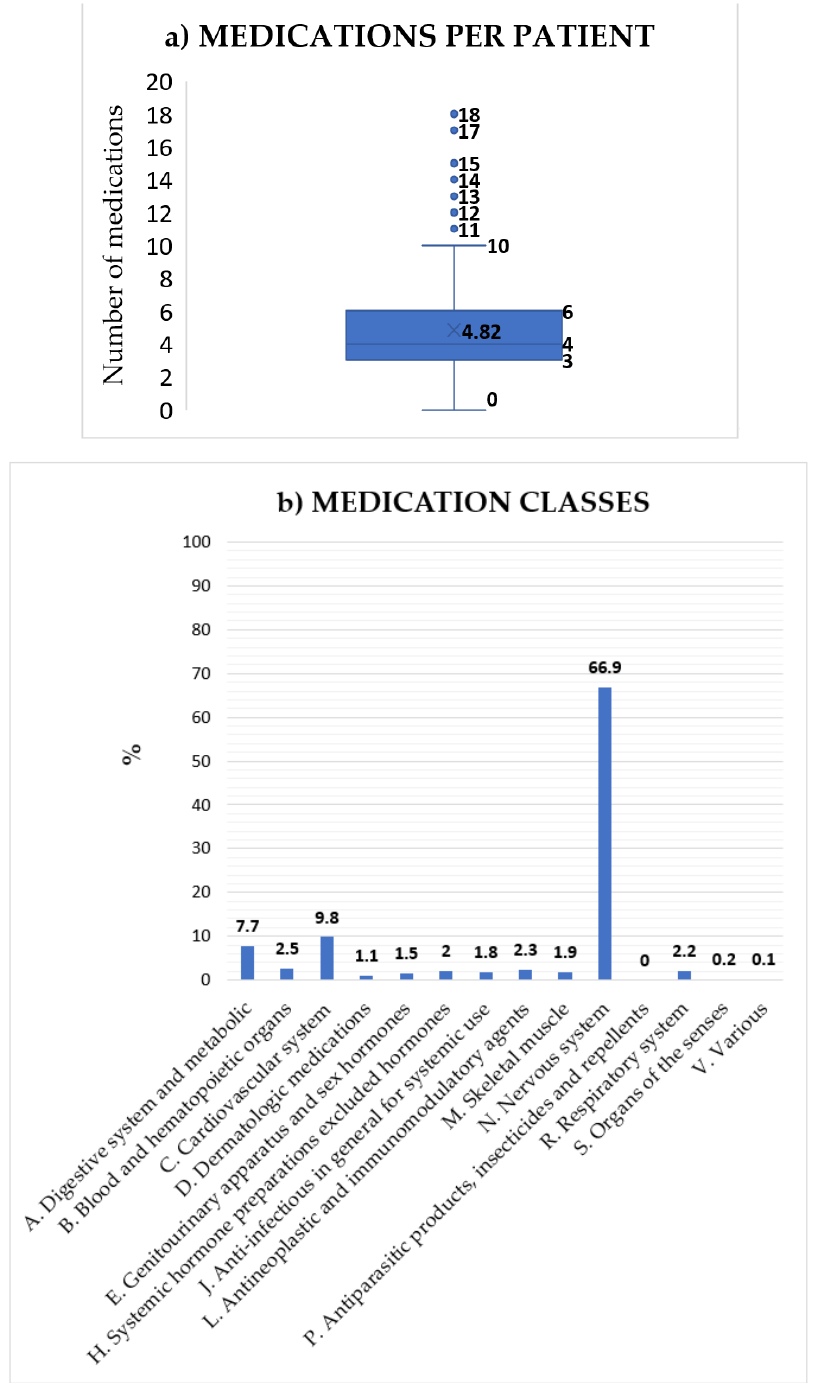
Figure 1. Medication-use data: ( a ) number of medications per patient (mean); ( b ) type of medication. Psychiatric patients most often complained that the drug did not help (83.9%), con- trasting patients seen in the allergy department, which reports that 75% had adverse events Half of the patients were female (49.5%). The mean age is 43.9 ± 18.1 vs. 47.1 ± 18.8 in (Fisher’s p -value < males. Supplementary Figure S3 shows a box plot with the age distribution. No statisti- cally significant differences were observed between both groups according to age (Fisher’s p -value = 0.21). Fifteen % of the patients were older than 65 years of age. Of the enrolled patients, 92.5% had neuropsychiatric disorders, mainly psychosis, depression, and bipolar